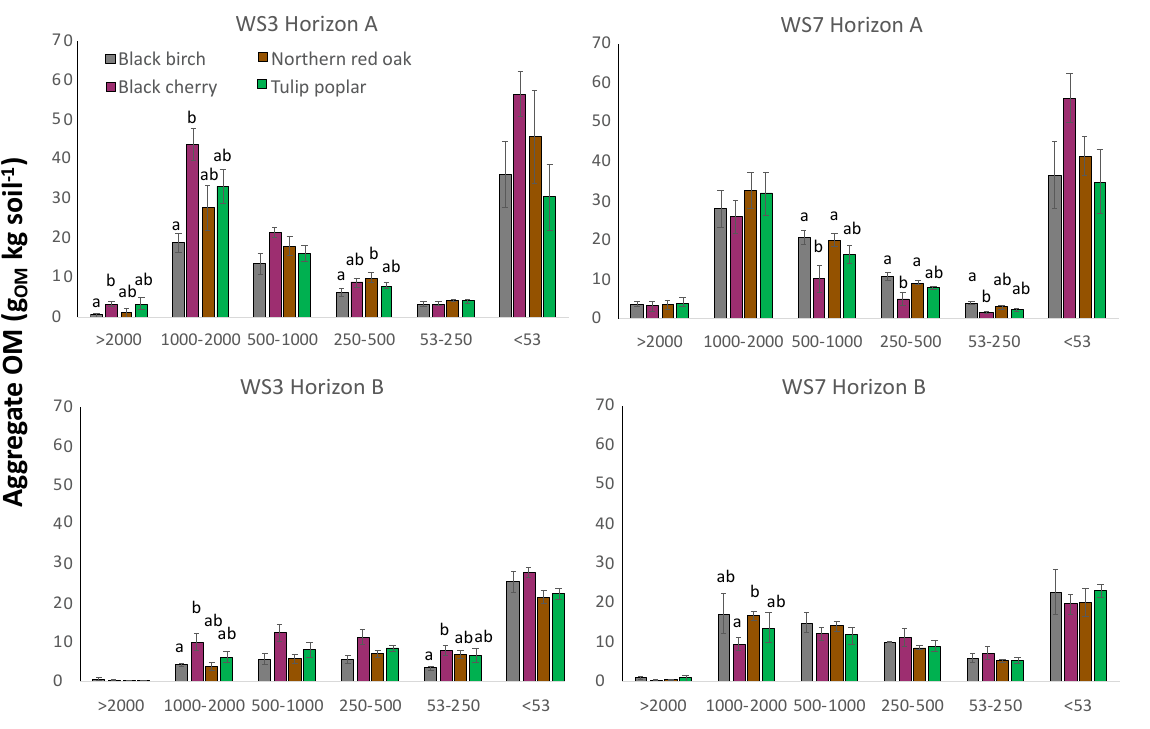
Figure 4. Organic matter within each aggregate size class by tree species in A-horizon and B-horizon (WS3-FERT and WS7-REF): for each horizon within each watershed, bars with different letters within each aggregate size fraction are significantly different according to Kruskal–Wallis pairwise means comparison ( p < 0.05).